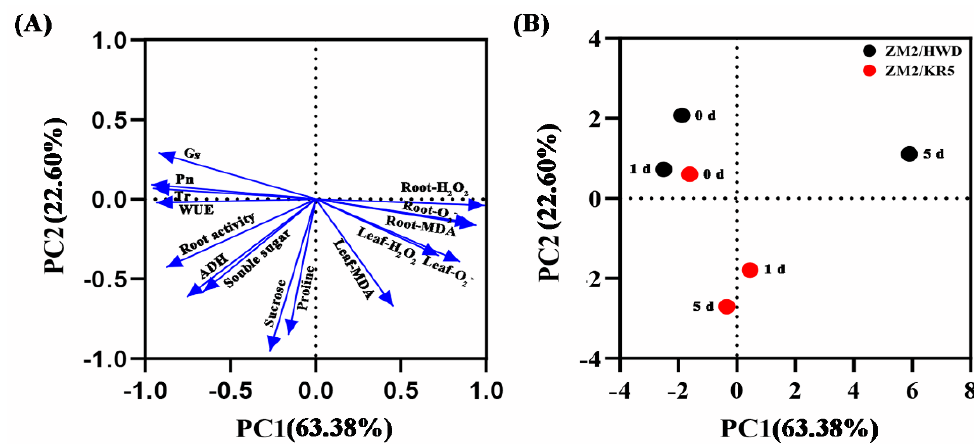
Figure 6. ( A ) PCA loading plot and ( B ) score plot showing the effects of two different rootstocks on the waterlogging tolerance of scion–rootstock combinations. ZM2/HWD and ZM2/KR5 indicate grafting ‘Zhongmi 2 (cid:48) onto ‘Hayward’ and KR5 rootstocks,